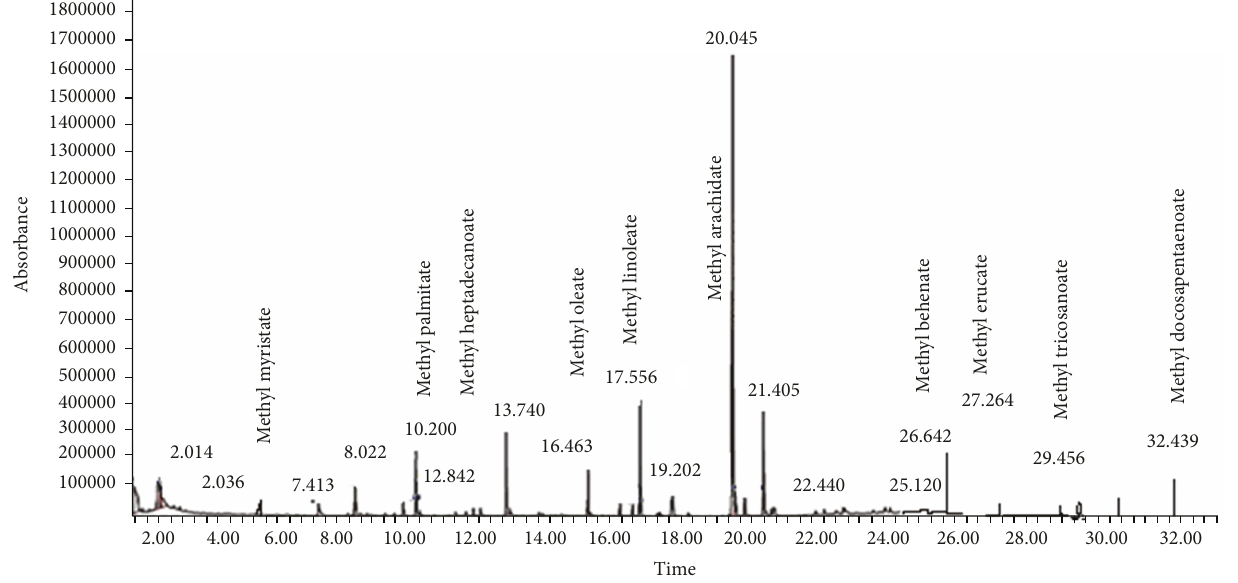
Figure 1: GC chromatogram of Moringa oleifera seed